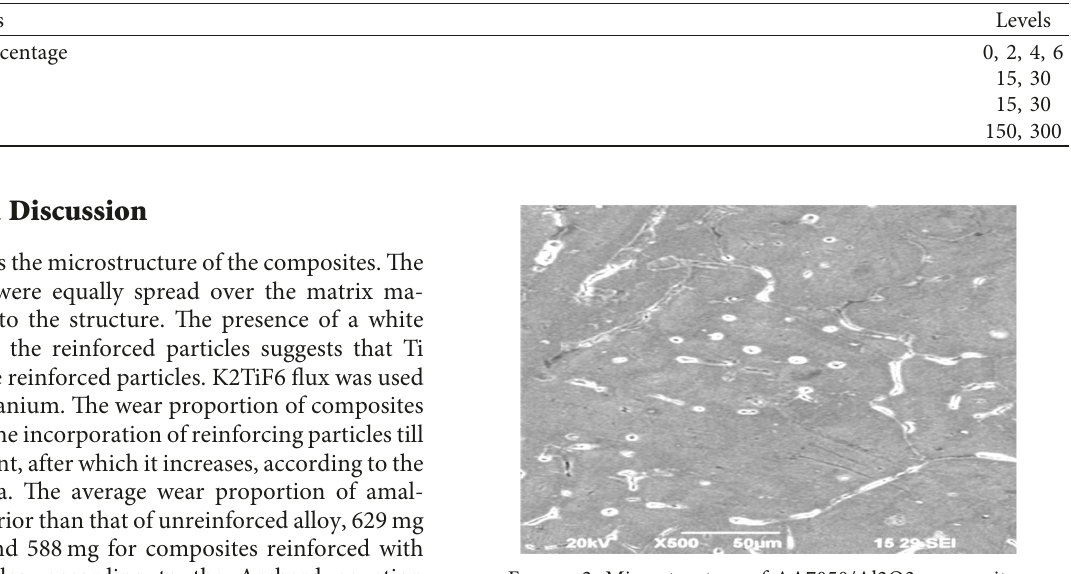
Table 3: Wear process parameters and their levels.